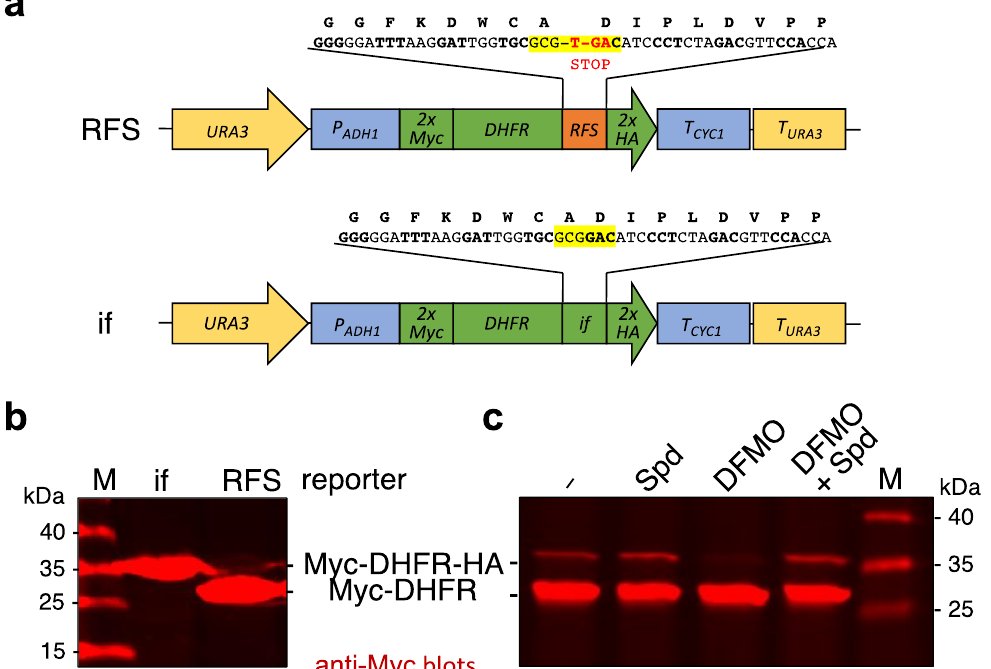
Figure 1. Reporter constructs with the OAZ1 ribosomal frameshift site (RFS). ( a ) Schematic repre- sentation of reporter constructs generated. Both reporter units are integrated downstream of the endogenous URA3 gene of S. cerevisiae strains. The reporter gene encompasses a sequence encoding two Myc epitopes, mouse DHFR, and either 49 nucleotides derived from the OAZ1 gene with the RFS site at the center, or 48 nucleotides with an in-frame (if) variant of the same, followed by a sequence encoding two HA tags. Expression of these reporter genes is controlled by the P ADH1 promoter and the T CYC1 transcription terminator. ( b ) Detection of reporter proteins expressed either from the construct with the ribosomal frameshift site (RFS), or from its in-frame (if) variant as depicted in ( a ). The cells were grown to exponential phase in complete medium (yeast extract, peptone, dextrose/YPD; see Section 4.1). Cell extracts were analyzed by SDS-PAGE and anti-Myc Western blotting. ( c ) Western blot analysis of cells expressing the RFS reporter construct grown for 4 h in synthetic defined (SD) media with glucose and supplemented with 100 µM spermidine (Spd), 5 mM difluoromethylornithine (DFMO), or both, as indicated. Positions of the full-length reporter with 2xHA tag or of the shorter version without it, as well as of the size markers are indicated.